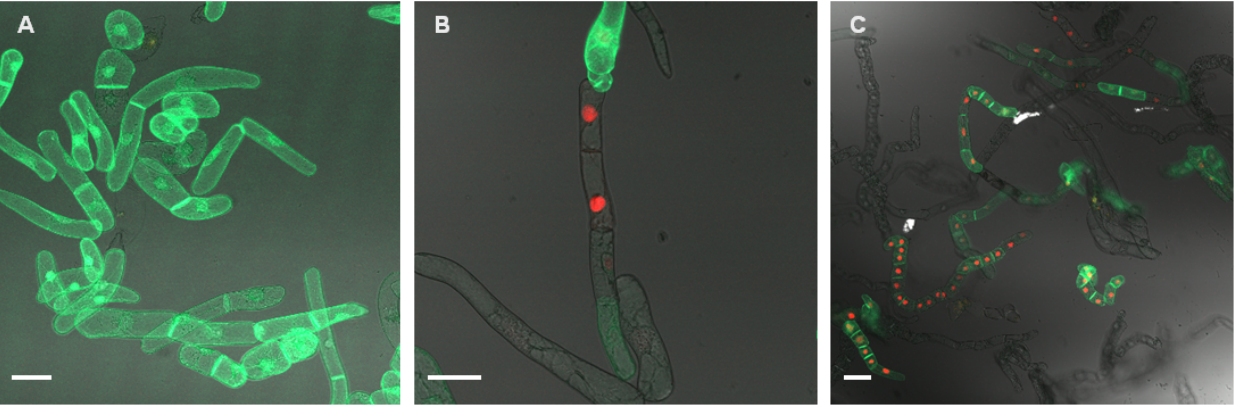
Figure 9. Restoration of RFP fluorescence after treatment with 5-azacytidine. A : Double fluorescent cell line that suddenly lost mRFP expression. B and C : Cells were treated with 10 µM azacytidine for one week. RFP fluorescence could be recovered, but many dead cells were due to overall toxic effects. Even though the concentration was scaled down 10–20x compared to values that are indicated in the literature for treatments, the concentration still seemed to be too high for the use in tobacco BY-2 cells (which have a good uptake rate and fast metabolism). All images are shown as merged images taken in green and red fluorescence, as well as white light mode. White bars = 50